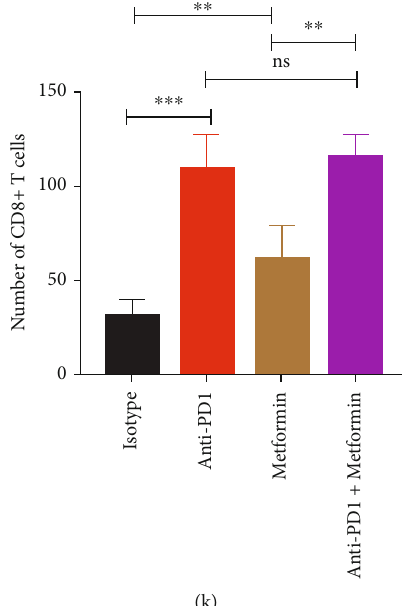
Figure 3: Metformin inhibits colon tumor growth and has no e ff ect on tumor immune responses to anti-PD1. (a) Schematic overview of experimental design combined for (b) – (k). (b – d) Tumor growth (b) and weight (c) from MC38 tumor-bearing C57BL/6 mice were shown ( n = 7 ). (e – g) Tumor growth (e) and weight (g) from CT26 tumor-bearing on BABL/C mice were shown ( n = 7 ). (h and i) Sections from MC38 subcutaneous tumors were stained with anti-CD8 antibody by immunohistochemistry (h), and CD8 + T cells in fi ltration were analyzed in (i). (j and k) sections from CT26 subcutaneous tumors were stained with anti-CD8 antibody by immunohistochemistry (j), and CD8 + T cells in fi ltration were analyzed in (k). Scale bars: 100 μ m. Data were analyzed by two-way ANOVA (b and e) and t -test (c, f, i, and k). ns: no signi fi cance; ∗ p < 0 : 05 , ∗∗ p < 0 : 01 , and ∗∗∗ p < 0 : 001 . Error bars denote for the